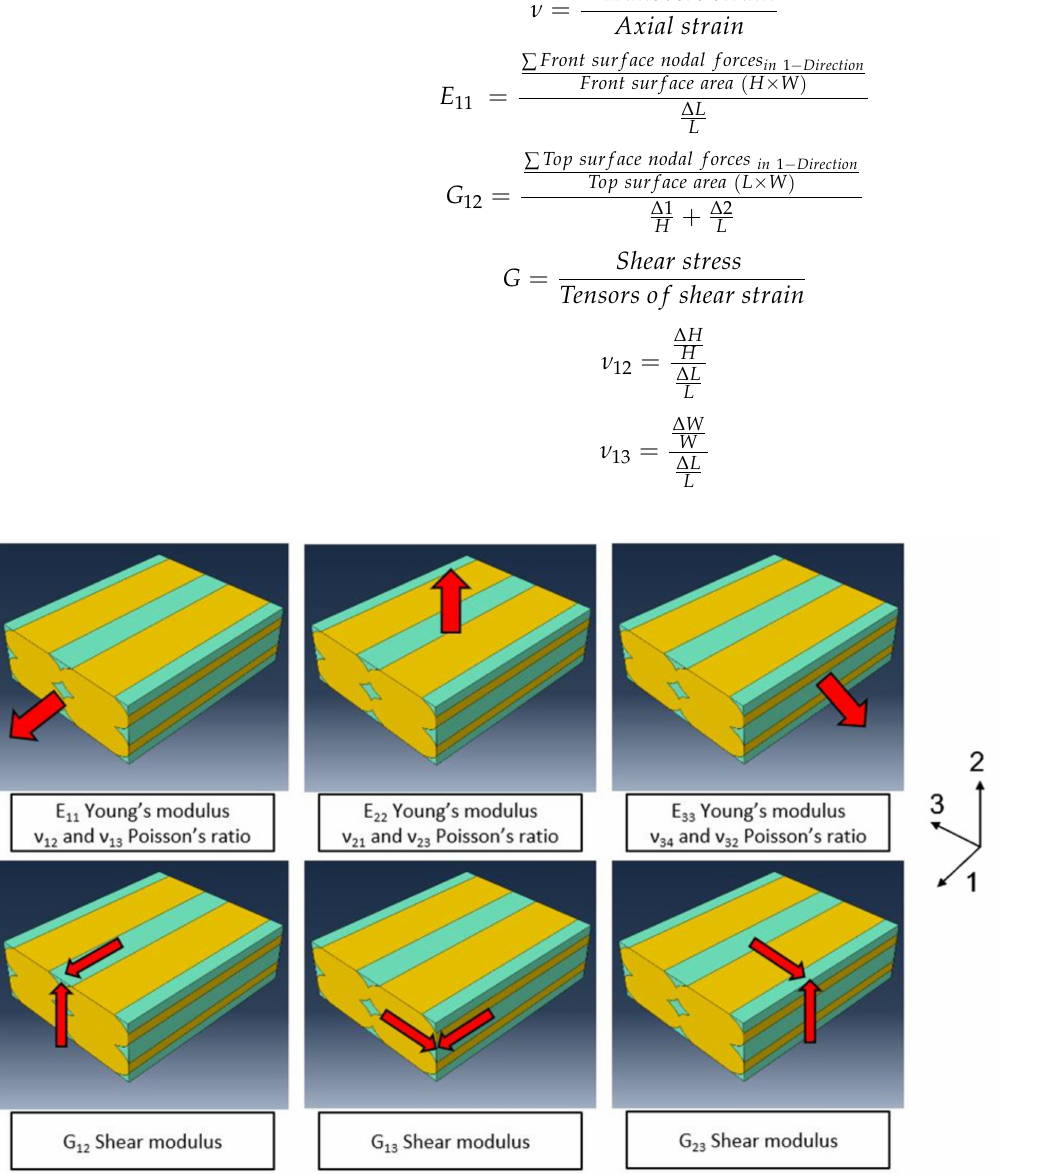
Figure 6. Load cases in the RVE model. The red arrows indicate the directions of the imposed displacement on the RVE. Software axes 1, 2, and 3 indicate the X, Y, and Z